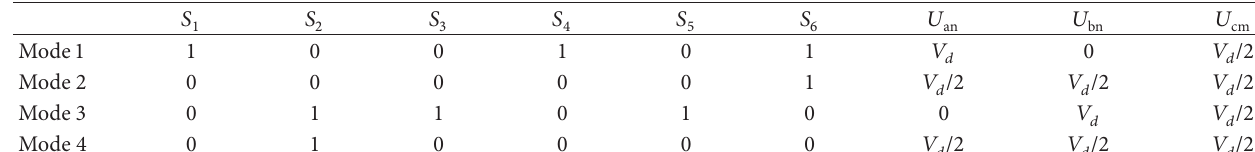
Table 1: Operation modes and voltages.